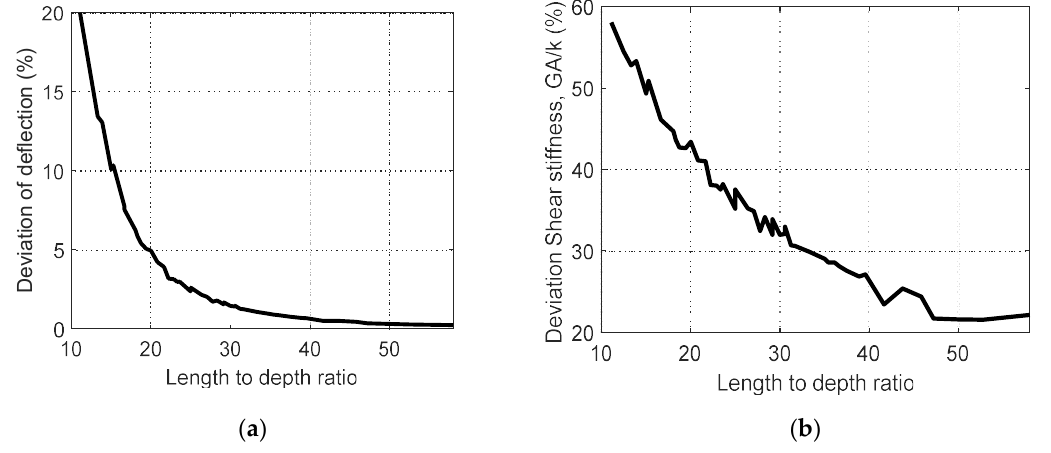
Figure 10. Deviation of ( a ) deflection and ( b ) shear stiffness against changing span-to-depth ratio of Timoshenko method from FE models.